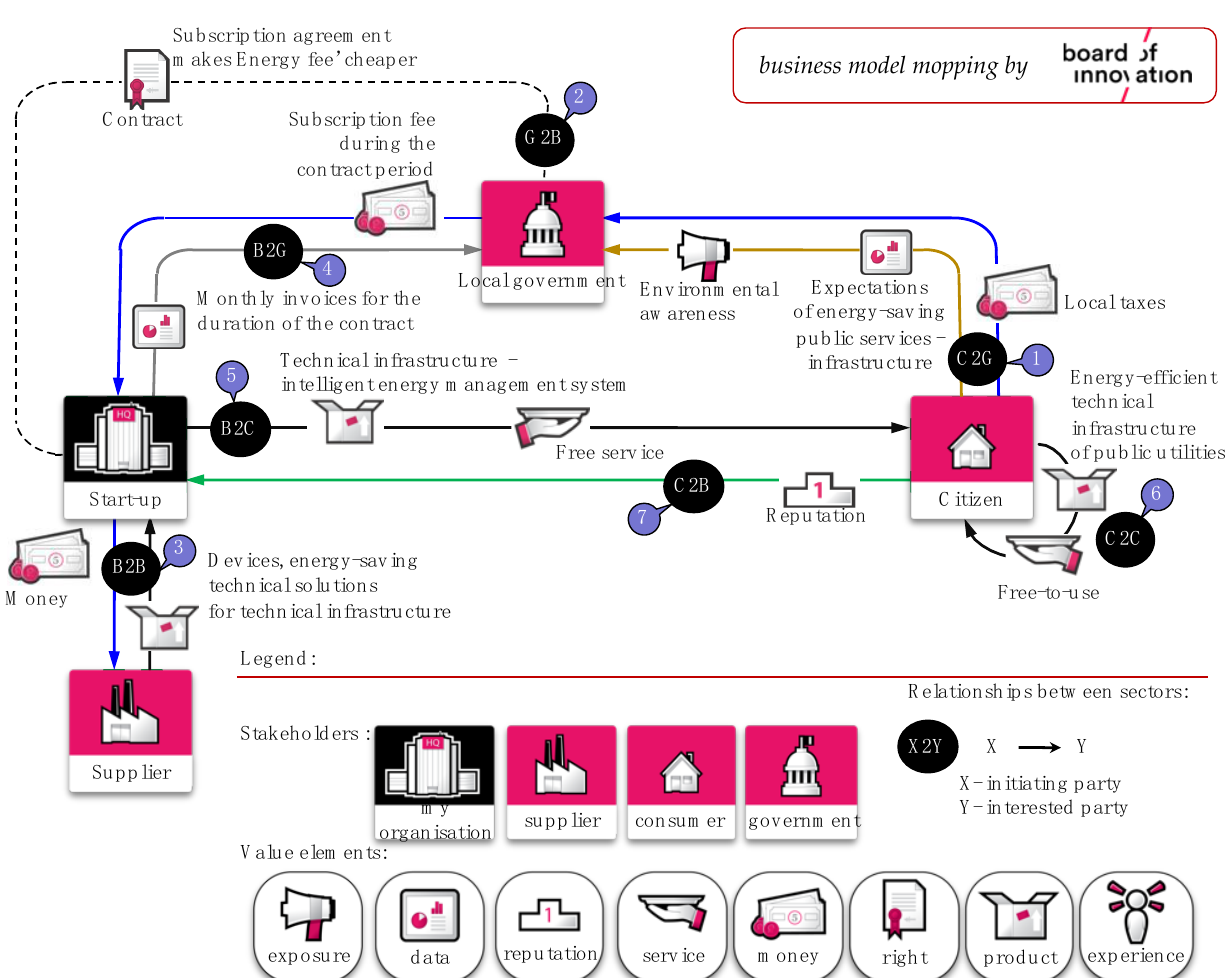
Figure 4. Visualization of the ecosystem business model for a start-up. The Source: Own study based on the BoI [47].